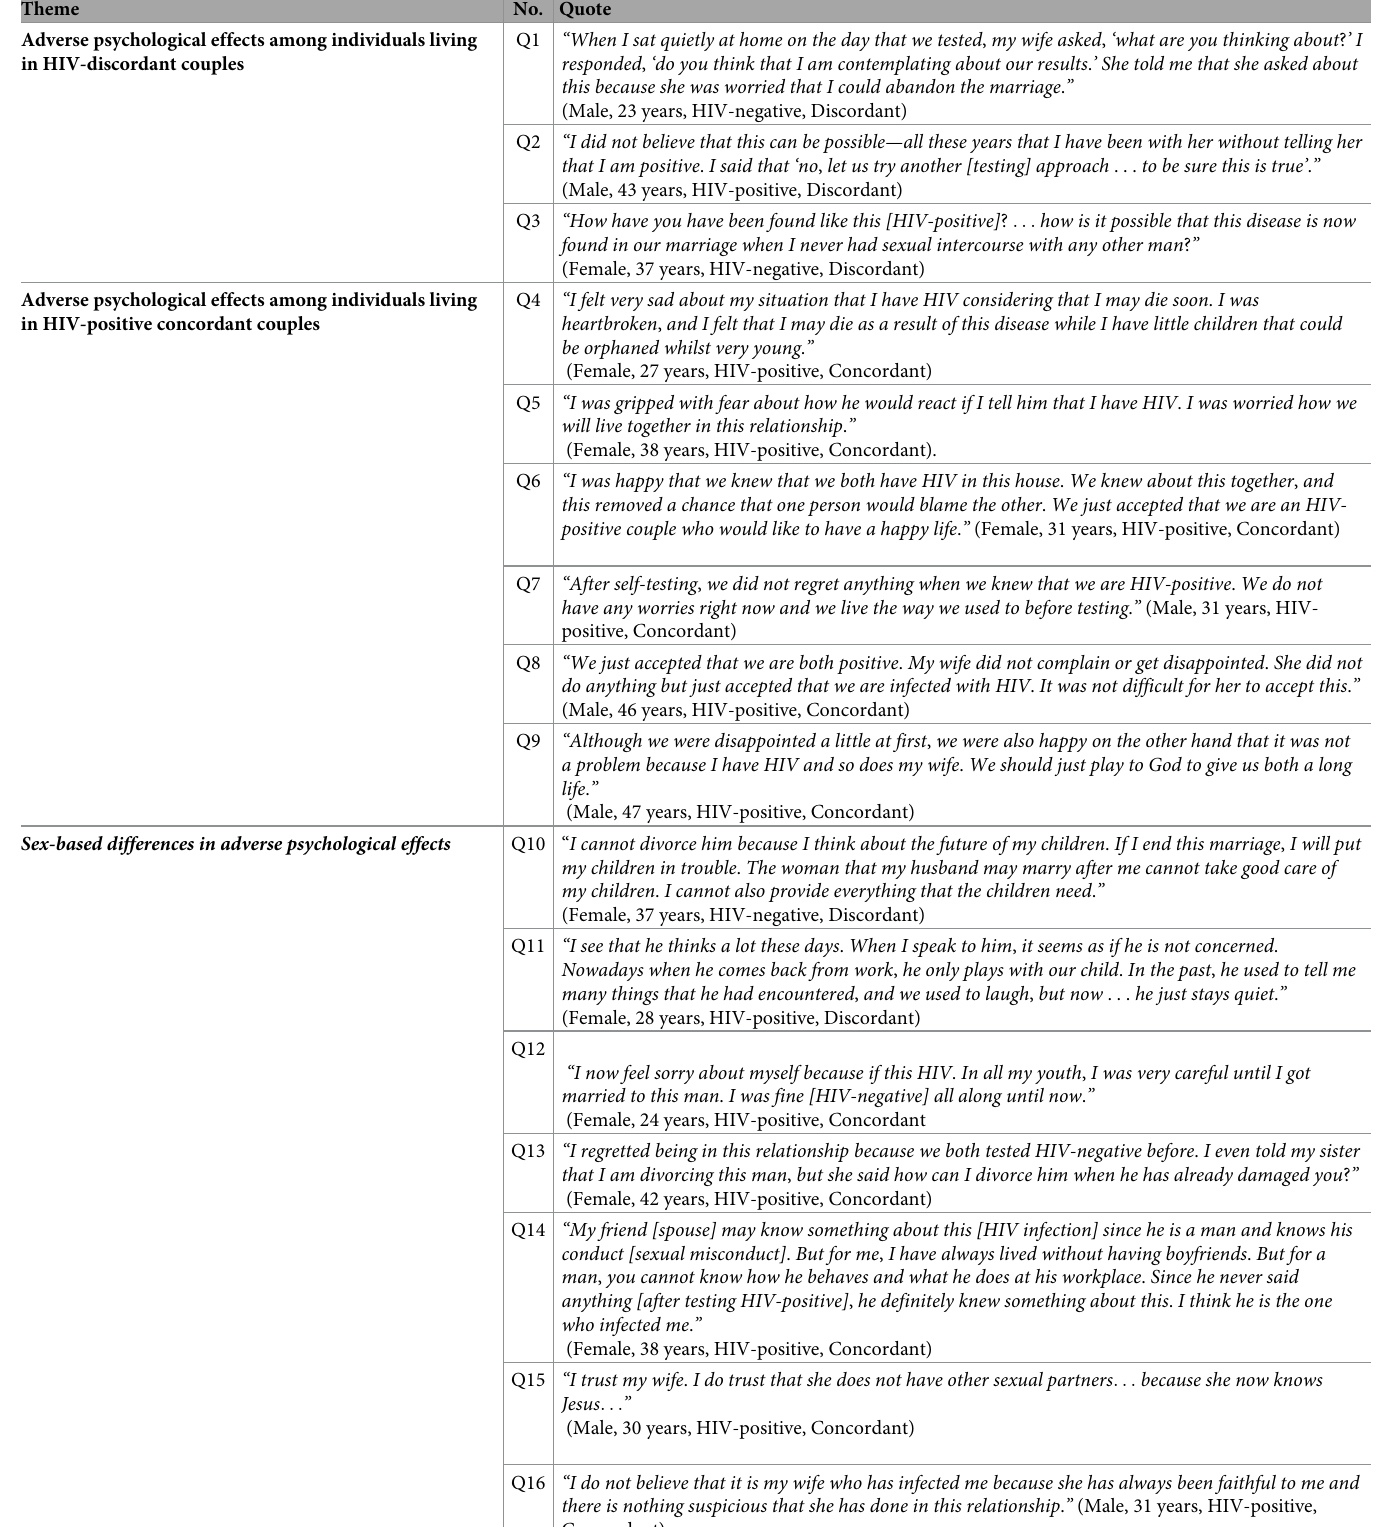
Table 2. Quotes on adverse psychological effects and coping abilities.